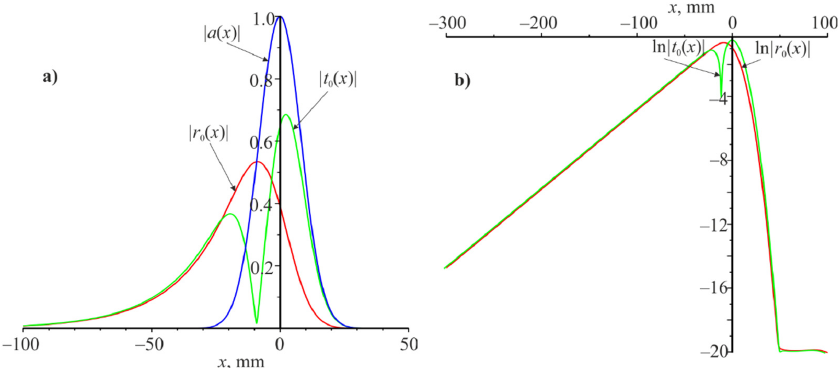
Figure 5. Amplitude modulus distribution | a ( x ) | , | r 0 ( x ) | and | t 0 ( x ) | along the x coordinate ( a ) and distribution ln | r 0 ( x ) | and ln | t 0 ( x ) | along the x coordinate ( b ). Resonant wavelength is 1.064 µ m and resonant angle is θ = 20 o at the L = 20